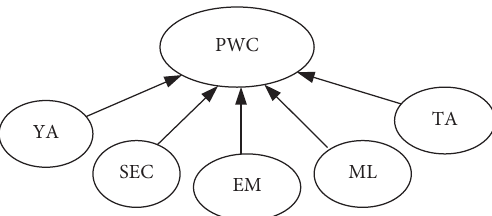
Figure 5: The threat assessment model for the UUV’s working